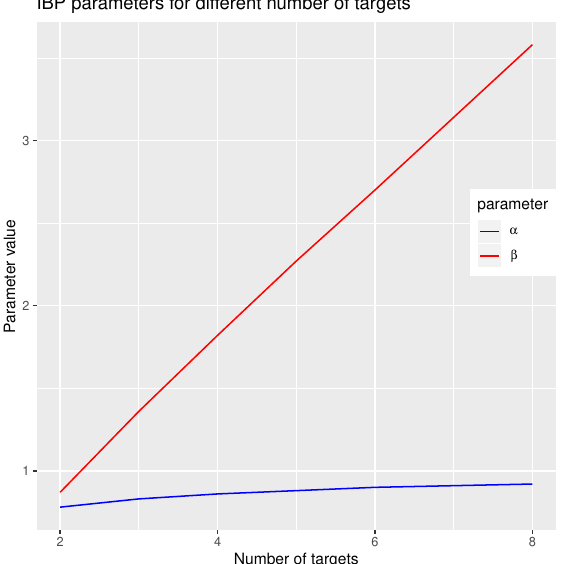
Figure 1. Indian buffet process (IBP) prior parameter values for which the ideal assignment matrix has maximum